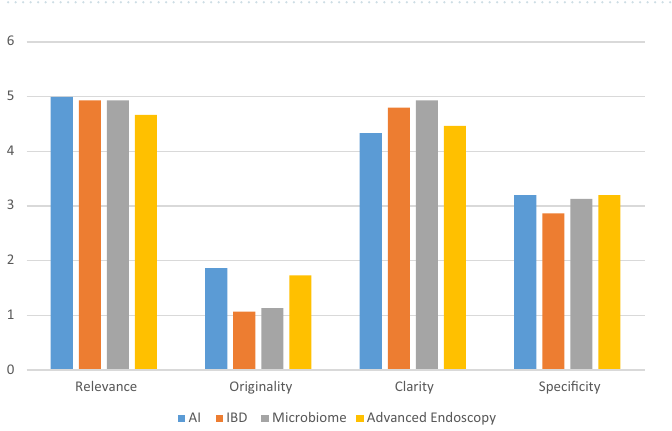
Figure 1. Level of inter-rater agreement and the mean grades in all categories for every topic. The figure illustrates the level of inter-rater agreement and the mean grades in all categories for every topic. When the curves representing the ratings of different evaluators are closer together within the circle, it indicates a higher level of agreement among them. The further the curve is from the outer edge of the diagram, the higher the grades given by the evaluators. The monotonic nature of the curves suggests that the raters are consistent between their assessments.